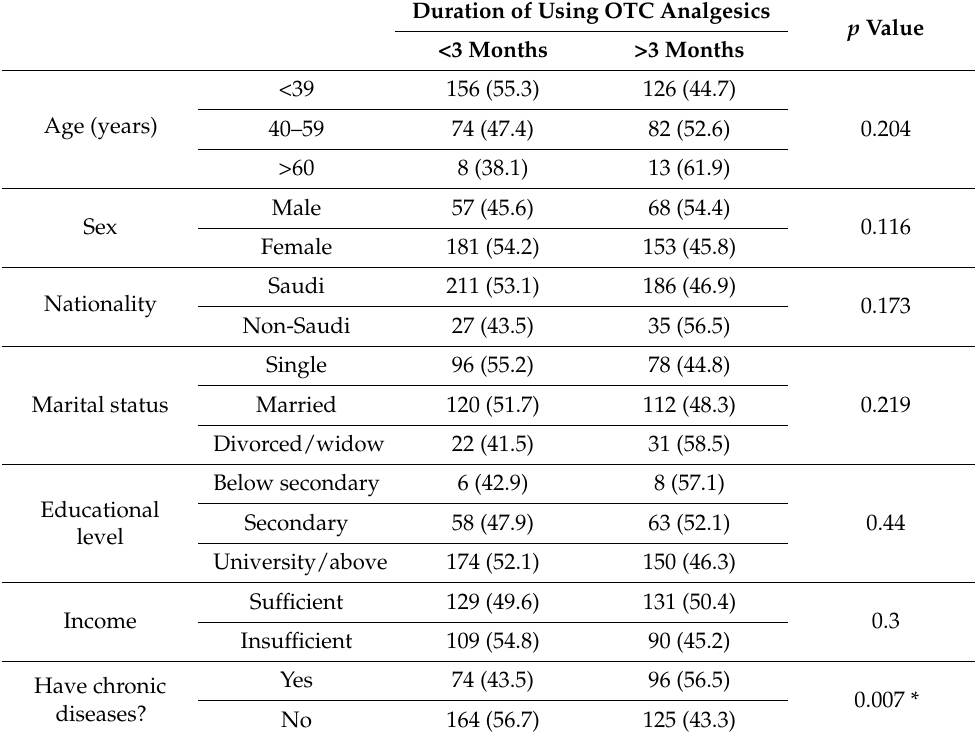
The association between sociodemographic characteristics and Over-the-Counter analgesic overuse. Duration of Using OTC